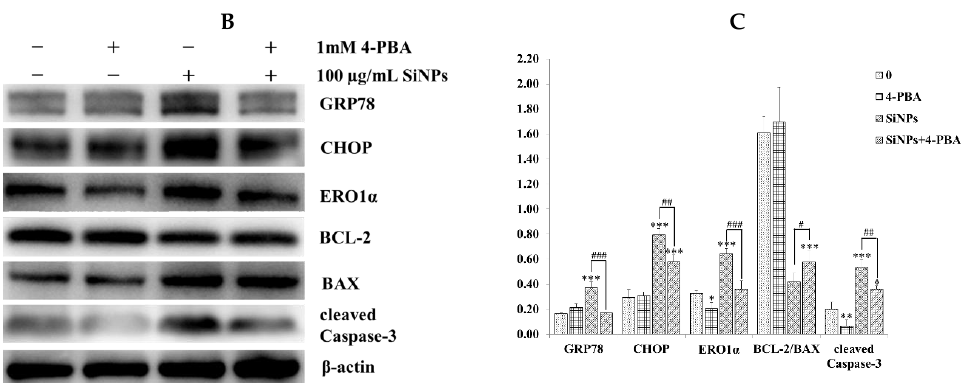
Figure 5. Effect of 4-PBA on the expression of the ER stress- and apoptosis-related proteins in SiNP-exposed RAW 264.7 macrophage cells. ( A ) Confocal immunofluorescence photomicrography showed the expression of GRP78 (green fluorescence) and CHOP (red fluorescence) in the control (the upper panels), SiNP (the center panels) and SiNP + 4-PBA cells (the bottom panels). RAW 264.7 macrophages were pretreated with 1 mM 4-PBA for 1 h, and exposed to 100 µg/mL SiNPs for 12 h. Scale bars, 20 µm. ( B , C ) Western blot analysis of GRP78, CHOP, ERO1α, BCL-2, BAX, and cleaved Caspase-3 in SiNP-exposed RAW 264.7 macrophage cells for 12 h. The analyses of the band intensities on films are presented as the relative ratio of target proteins to β-actin. Statistical analysis is shown in the bar graphs. Data are presented as the mean ± SDM of three independent experiments. Statistically different from the control is marked with asterisks (* p < 0.05, ** p < 0.01, and *** p < 0.001), and statistically different from SiNPs is marked with number sign (# p < 0.05, ## p < 0.01, and ### p < 0.001).